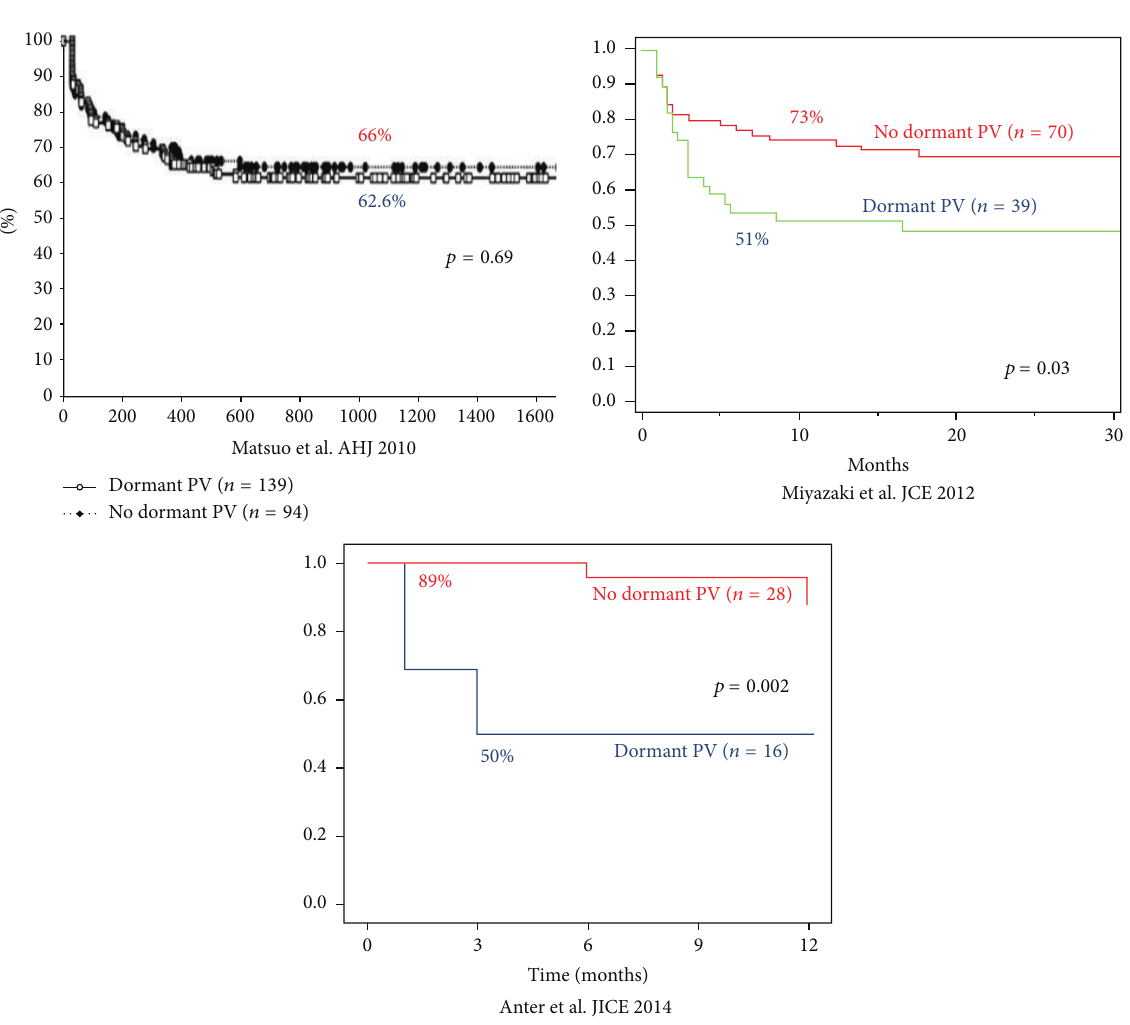
Figure 3: Freedom from AF in three nonrandomized studies comparing patients with adenosine induced reconnection and reablation (dormant PV) versus no reconnection [15, 17, 18]. PV: pulmonary